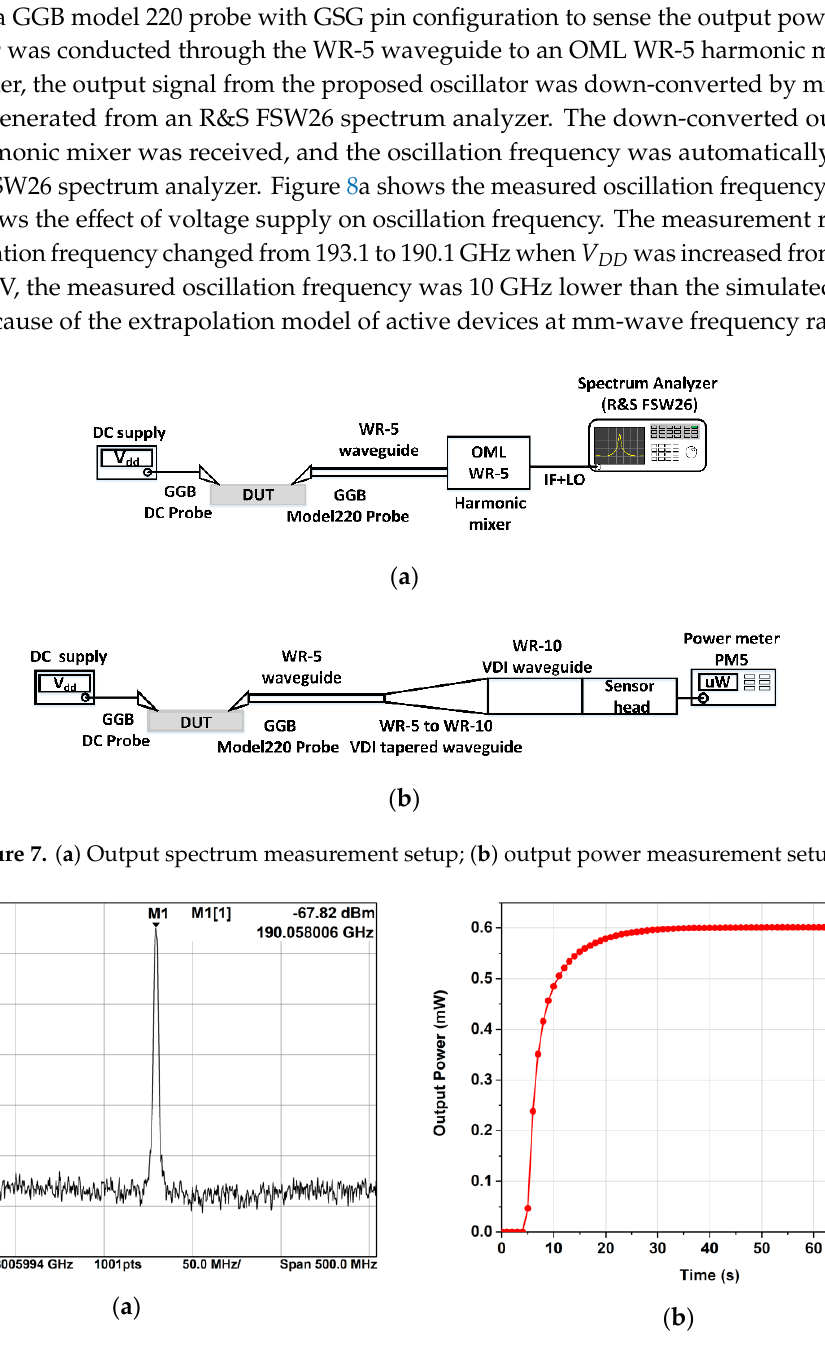
( b ) Figure 9. ( a ) Measured oscillation frequency and simulated oscillation frequency; ( b ) measured output power and simulated output power of the proposed oscillator with the change of voltage supply V DD . Table 1 shows the performance comparison of this work with the previous state of the art. The proposed oscillator generates a competitive output power at a high fundamental frequency with a